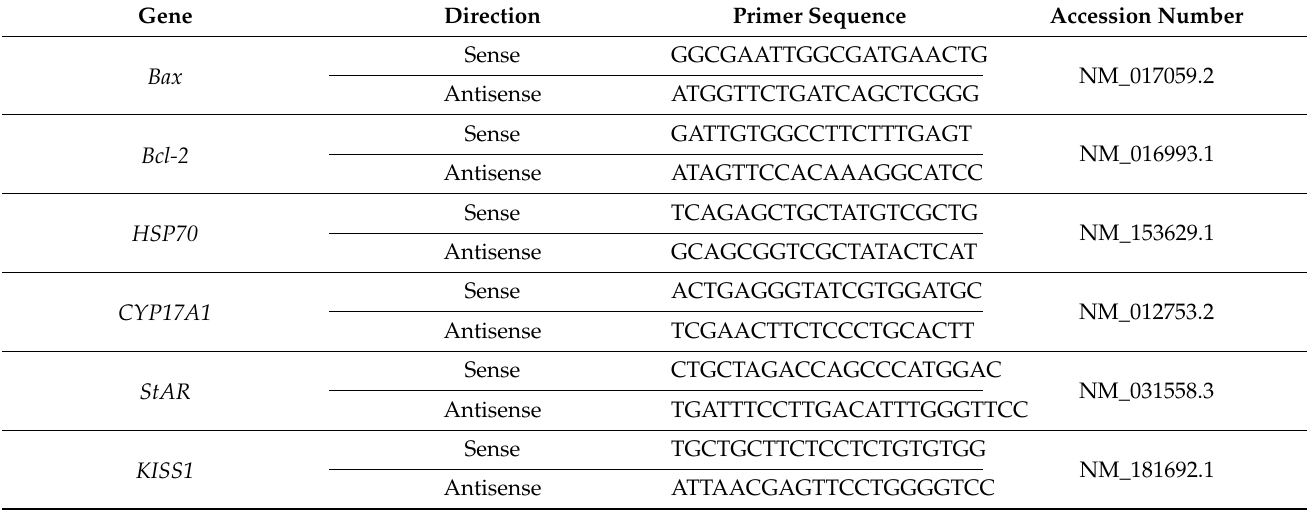
Table 1. Primers for gene expression by